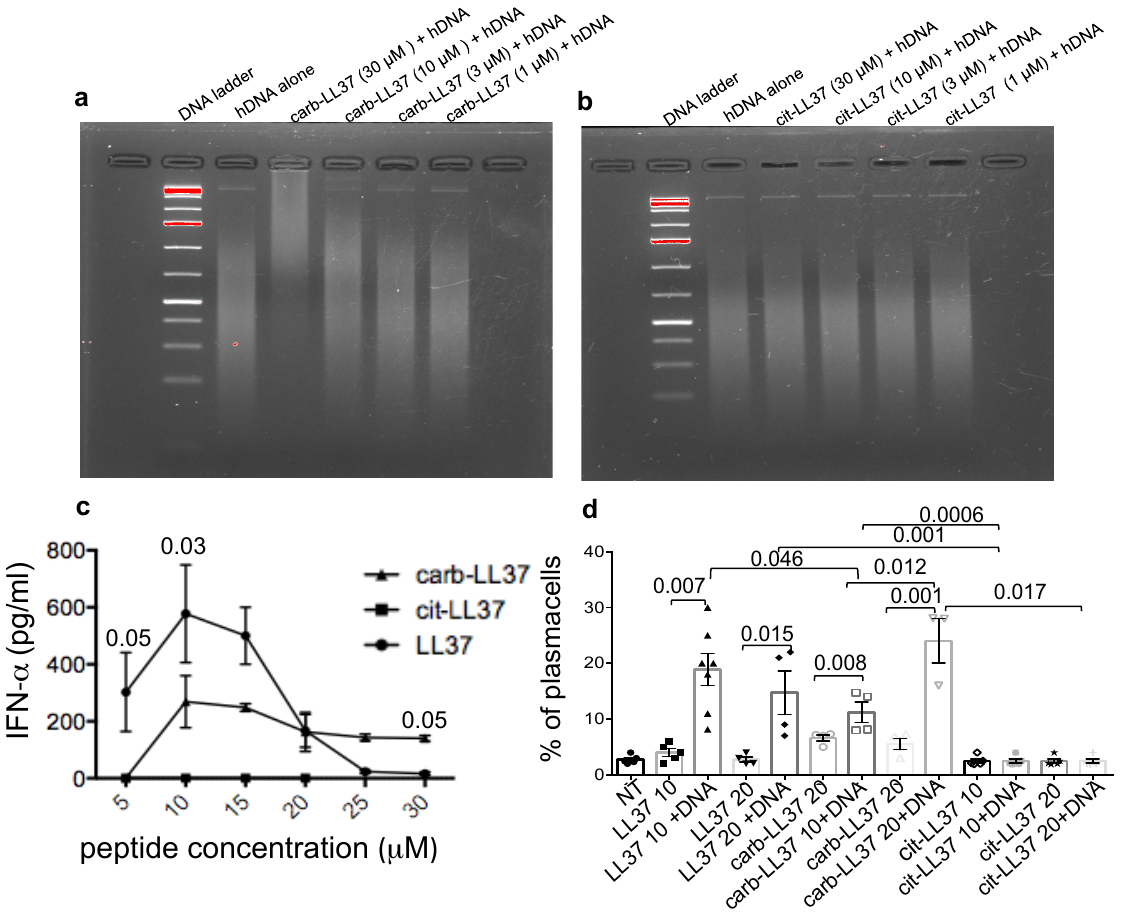
Figure 6. Carb-LL37, unlike cit-LL37, binds DNA and activates pDCs and B-cells. ( a , b ) EMSA, performed with carb-LL37 ( a ) and cit-LL37 ( b ), to show binding to DNA on a 2% agarose gel. Representative experiments of 3-to-5 performed. ( c ) Purified pDCs were stimulated with different µ M concentrations of carb-LL37, cit-LL37 or native LL37 pre-complexed with human DNA (the peptides alone and DNA alone induced no IFN- α response, therefore they are not reported in the picture). ( d ) Carb-LL37-, cit-LL37- and native LL37-DNA complexes or each peptides alone, were used to stimulate the differentiation of memory B-cells into plasma cells over a 7 days culture (in the presence of 50 UI/mL of hrIL-2). Percent of plasma-cells (CD19 − CD27 high CD38 high cells) was evaluated by flow cytometry. Cumulative data relative to 4-to-7 different experiments. Horizontal bars are the means; vertical bars are standard error of the mean; p -values by Student’s t test for paired